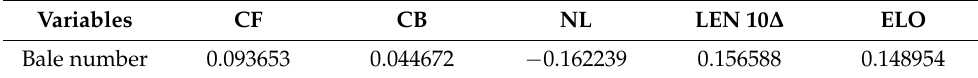
Table 3. Dependence of features on bale number—Spearman’s rank